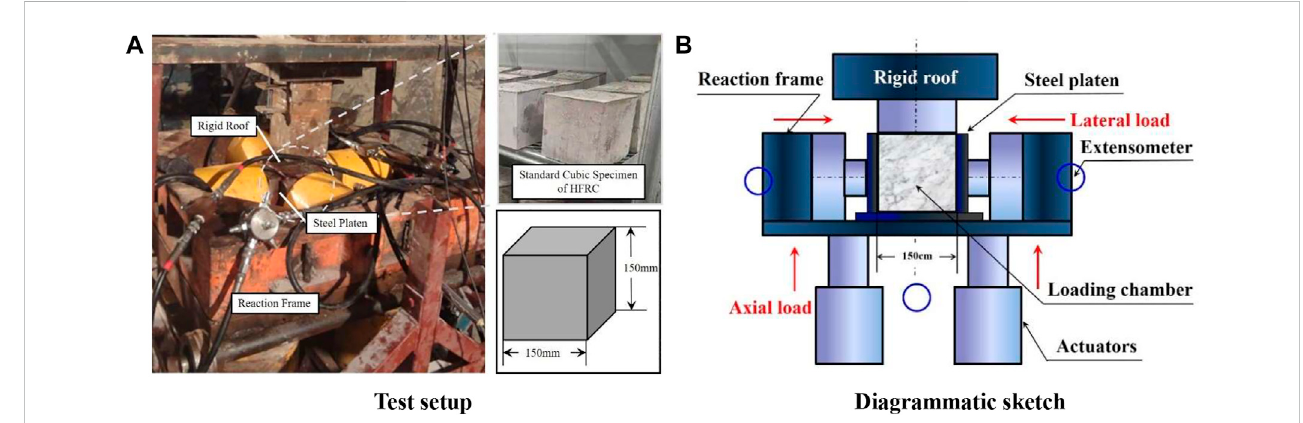
FIGURE 4 Installation of the cubic HFRC specimen. (A) Test setup. (B) Diagrammatic sketch.